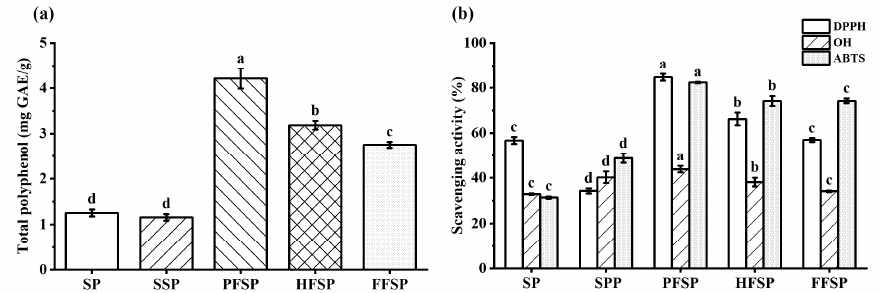
Figure 3. Changes in total polyphenol content (TPC) and antioxidant activity during the fermentation of different soybean meal powders. ( a ) Total polyphenol content; ( b ) scavenging activity. SP: soybean meal powder; SSP: sterilized soybean meal powder; PFSP: Pleurotus ostreatus fermented soybean meal powder; HFSP: Hericium erinaceus fermented soybean meal powder; FFSP: Flammulina velutipes fermented soybean meal powder. Data are mean ± SD of triplicates, values with different letters (a–d) present significant difference ( p < 0.05).